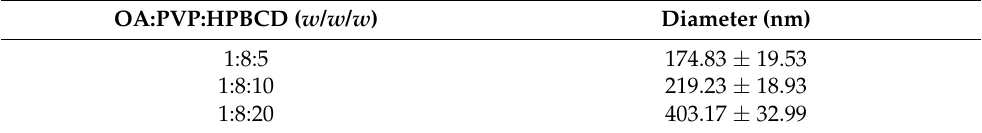
Table 1. Diameter of oleanolic acid and its nanofibers under scanning electron microscope (SEM).